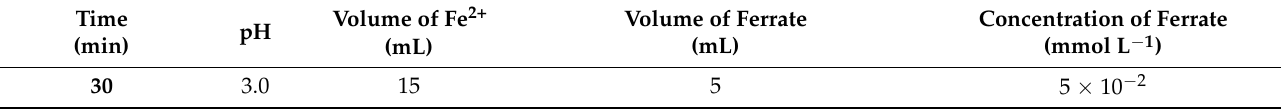
Table 3. Optimum conditions obtained all parameters with initial and final concentrations of Fe 2+ . Time